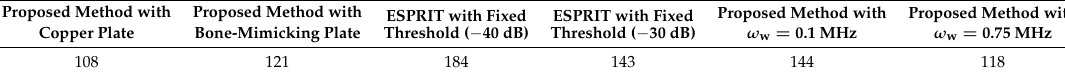
Figure 7. Wavenumbers of the 4-mm-thick bone-mimicking plate estimated using the proposed method and the conventional SVD method. Red dots show the estimates obtained using the proposed method. The color intensity map shows the results obtained using the conventional SVD method. Solid white lines show the theoretical curves. Table 1. Root mean square errors (RMSEs) of the experimental results with different settings. The units are